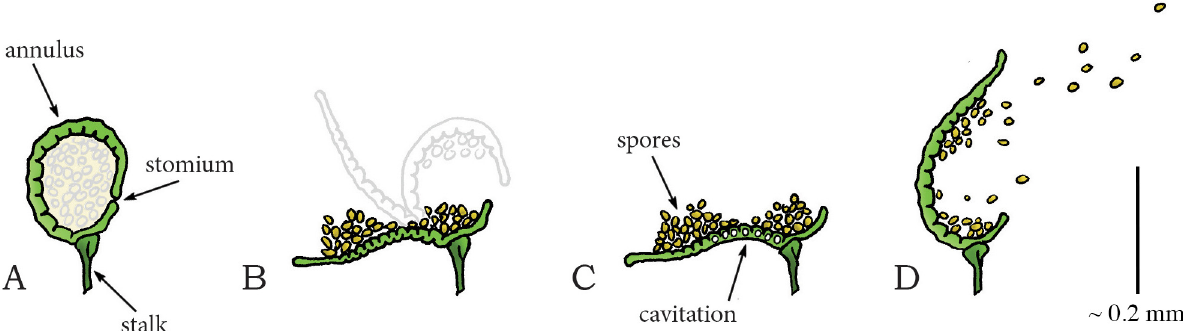
Fig 20. Cavitation catapult mechanism in the family Polypodiaceae or common ferns. (A) The mature sporangium in common ferns consisting of a stalk and an annulus enclosing the spores. (B) Dehydration of the annulus cells causes the radial cell walls to come closer together and the lateral walls to collapse internally, straightening the annulus. (C) When a critical pressure (between -9 and -20 MPa relative to ambient) is reached, cavitation occurs in the cells of the annulus. (D) Discharge of the spores by quick release of the elastic energy stored in the cell walls as the annulus snaps back to its original shape. Drawings based on high-speed images in [94]. Scale bar 0.2 mm (200 μ m). order: Selaginellales, family: Selaginellaceae), such as in Selaginella martensii , a spikemoss that